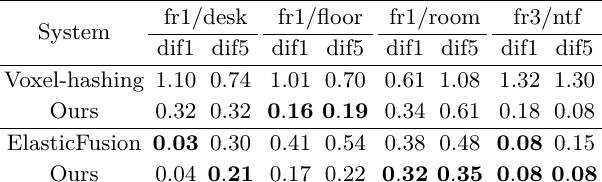
Table 1 Trajectory estimation comparison of methods using ATE metric System